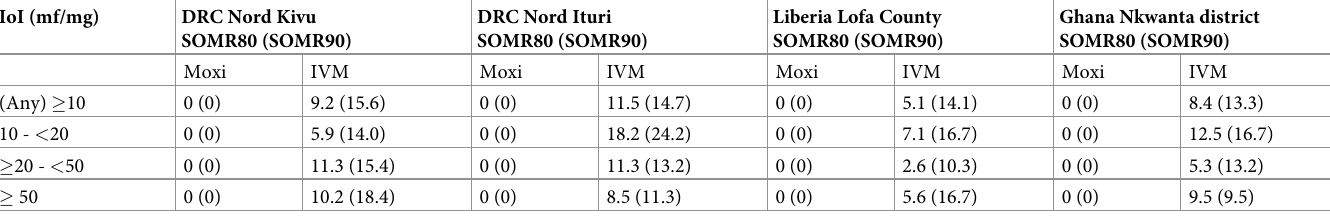
Table 4. Percentage of participants with ‘suboptimal microfilariae response’.